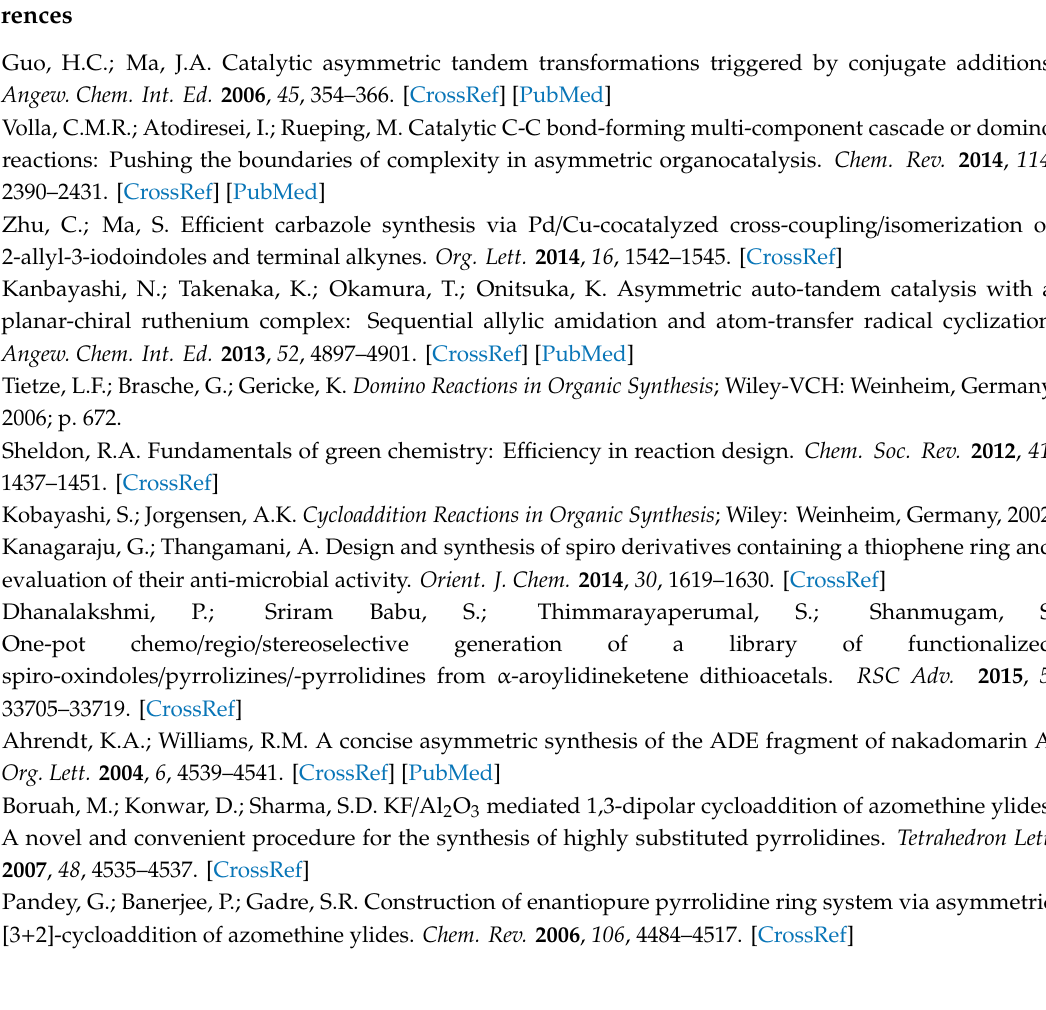
Supplementary Materials: The following are available online. Figures S1–S7: NMR and FT-IR spectra of a representative